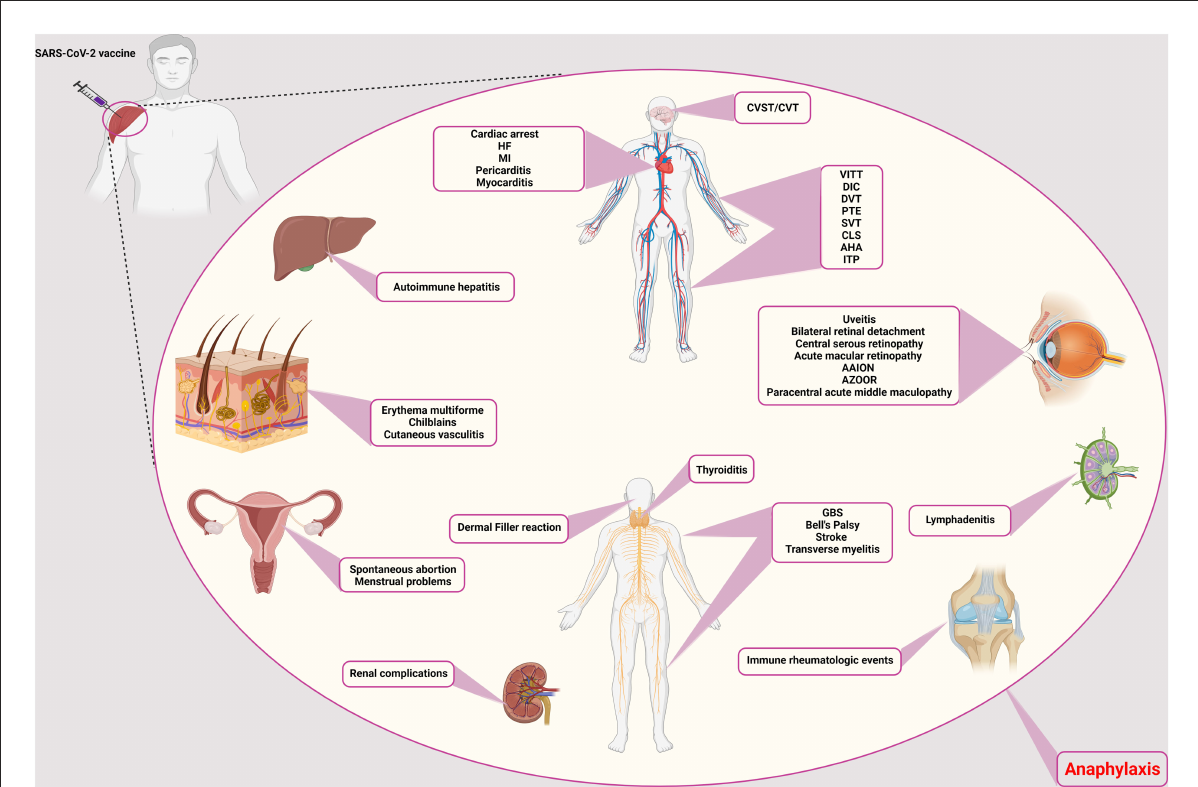
FIGURE1 Rare adverse events of COVID-19 vaccination. The side effects of the COVID-19 vaccines are different and can affect different systems and tissues in the body. Vascular side effects have been seen in the brain, vascular system of the limbs, abdomen, and heart, including CVST/CVT, VITT, DIC, DVT, PTE, CLS, AHA, ITP, SVT, cardiac arrest, HF, MI, pericarditis, and myocarditis, respectively. Ocular involvement includes uveitis, bilateral retinal detachment, central serous retinopathy, acute macular retinopathy, AAION and AZOOR, and paracentral acute middle maculopathy. The thyroid gland can also cause thyroiditis. Neurological side effects such as GBS, Bell’s palsy, stroke, and transverse myelitis have also been observed. It causes filler on the face. In addition to facial involvement, skin infections such as erythema multiforme, chilblains, and cutaneous vasculitis have also been reported. It causes autoimmune hepatitis in the liver and has caused many complications for the kidneys. Symptoms of immune rheumatologic events have also been observed in some patients. Lymphadenitis is one of the immune complications in the lymph nodes. In addition to the above, it also causes spontaneous abortion and menstrual problems in women. CVST/CVT, Cerebral venous sinus thrombosis/Cerebral venous thrombosis; VITT, Vaccine-induced immune thrombotic thrombocytopenia;